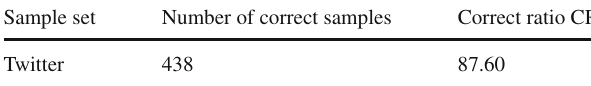
Table 3 Correct ratio CR of the sample set Sample set Number of correct samples Correct ratio CR Twitter 438 87.60